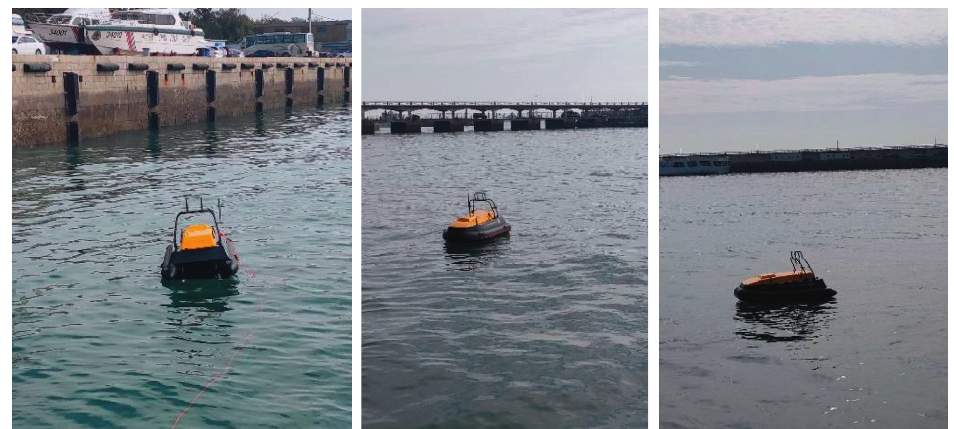
Figure 6: Shore experiment of